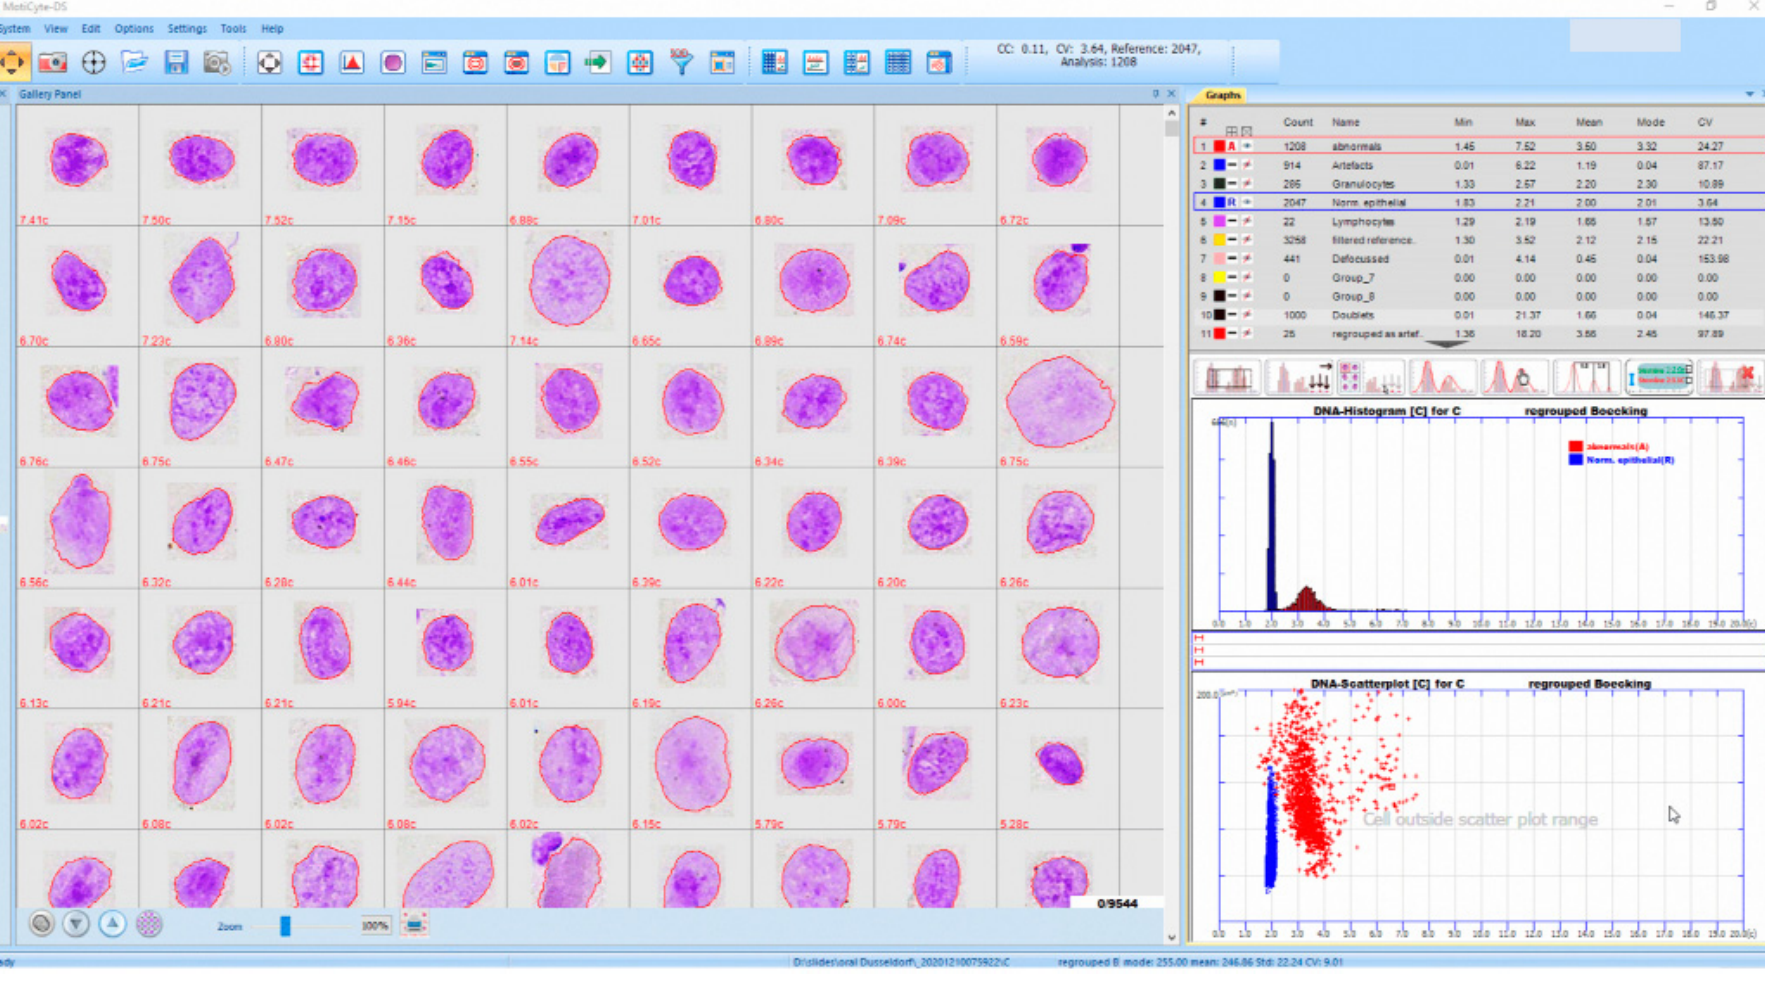
Figure 5. Interactive screen from an EasyScan-AI, presenting an image gallery of 63 Feulgen-stained, automatically classified cancer cell nuclei and their respective DNA contents ( left ), the respective DNA histogram and scattergram (area vs. DNA) ( right below ), and numbers plus statistical features of detected five nuclear types ( right above ).